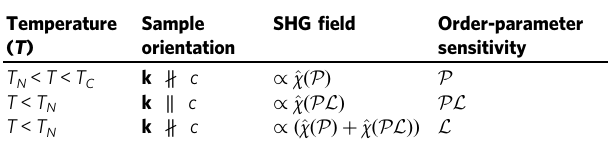
Table 1 Measurement con fi gurations to reveal SHG contributions proportional to P , PL and L